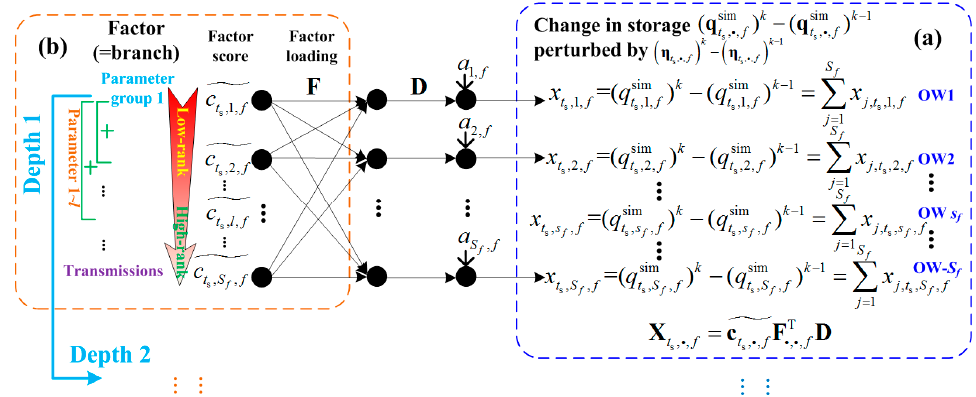
Figure 1. Schematic diagram of singular value decomposition of changes in storage between the k th and ( k − 1) th iterations with once simulation perturbation: ( a ) observed change in storage sim sim -1 ; ( b ) decomposed components of change in storage perturbed by the correction in , , s s the parameter